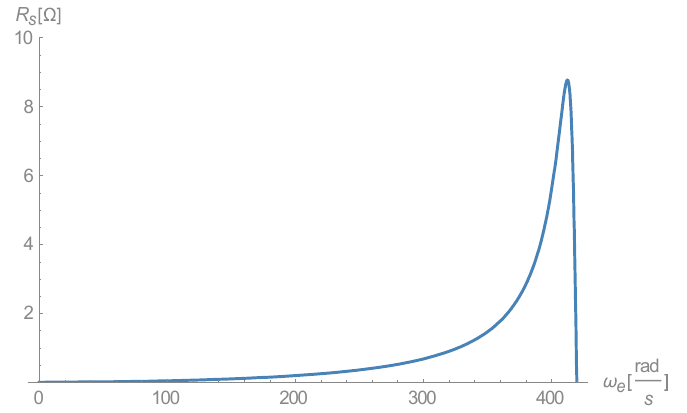
Figure 2. The critical resistivity relative to the angular speed as obtained in Equation (29).